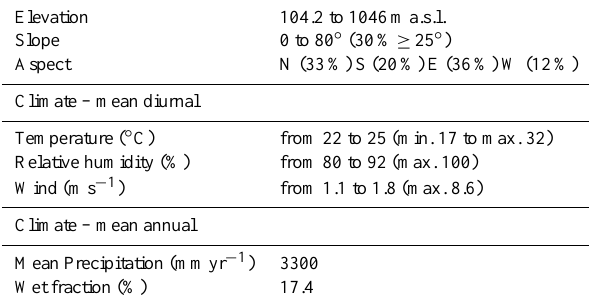
Table 1. Physiographic and climatic characteristics of the Mameyes Basin and of the meteorological station, Bisley Tower (352ma.s.l.): climate – mean diurnal, refers to the average variation of the vari- ables throughout the day (numbers in parentheses refer to the mini- mum and maximum of the series); climate – mean annual, refers to the yearly average of the variables.